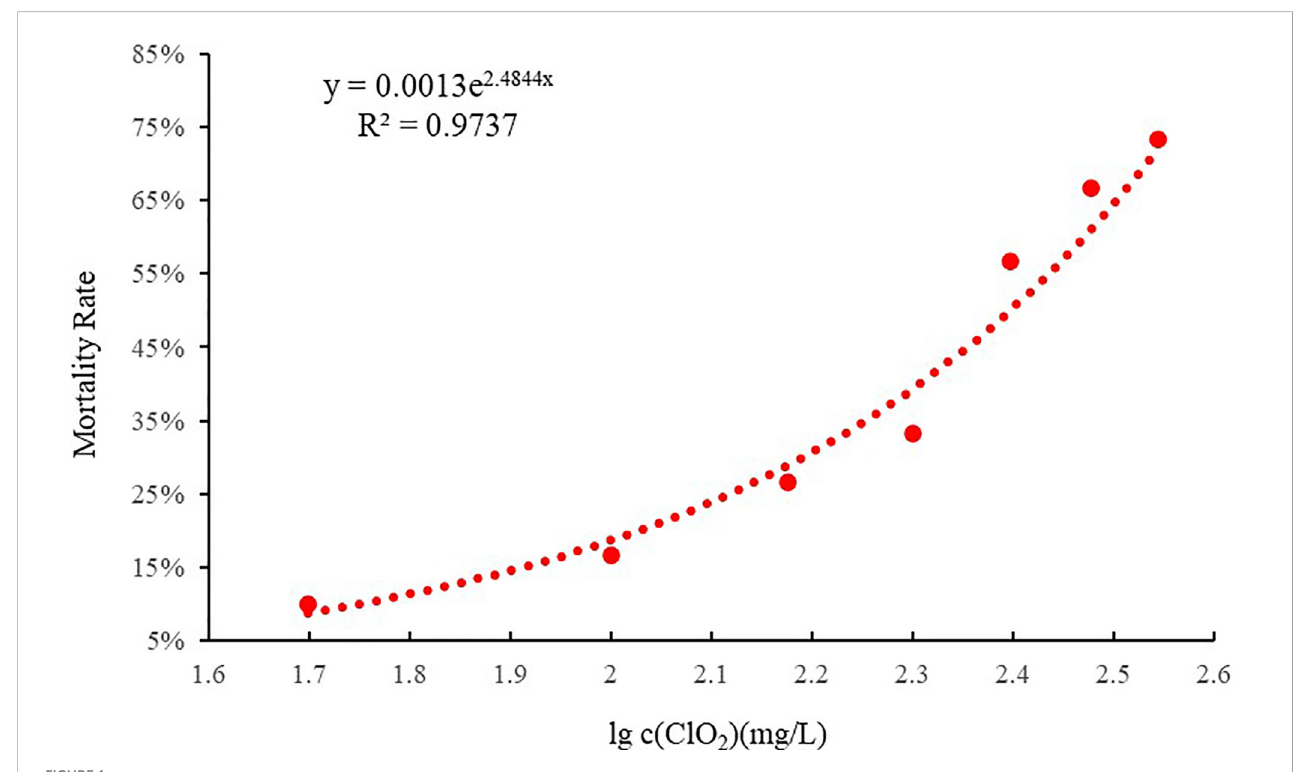
FIGURE 1 The Concentration - Mortality curve of chlorine dioxide to C. sinensis at 96 h (R 2 =